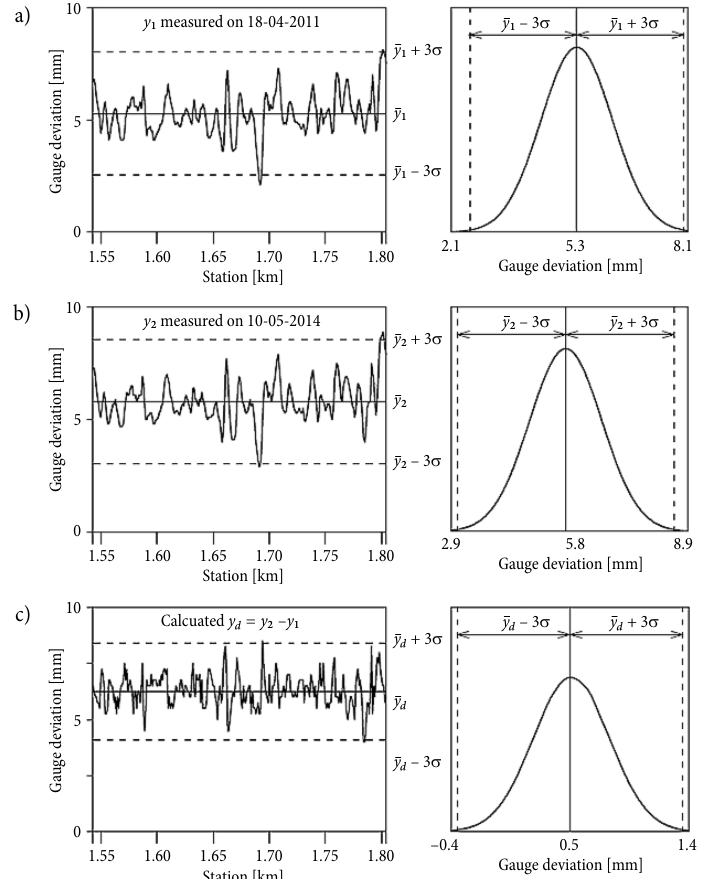
Fig. 3. Example of gauge data filtration on one of the observed track segments